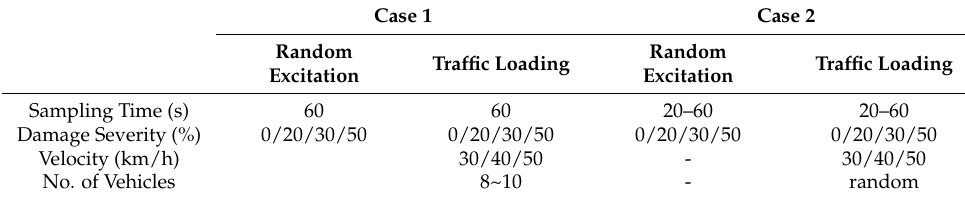
Table 3. Configurations of training